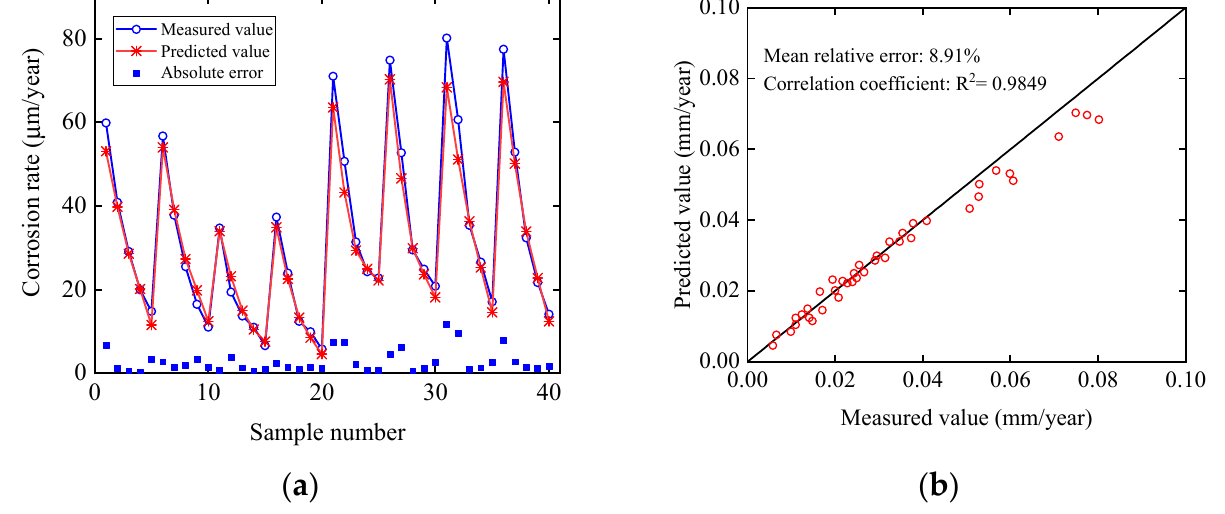
Figure 15. Evaluation results of the test set. ( a ) Comparison between measured values and predicted